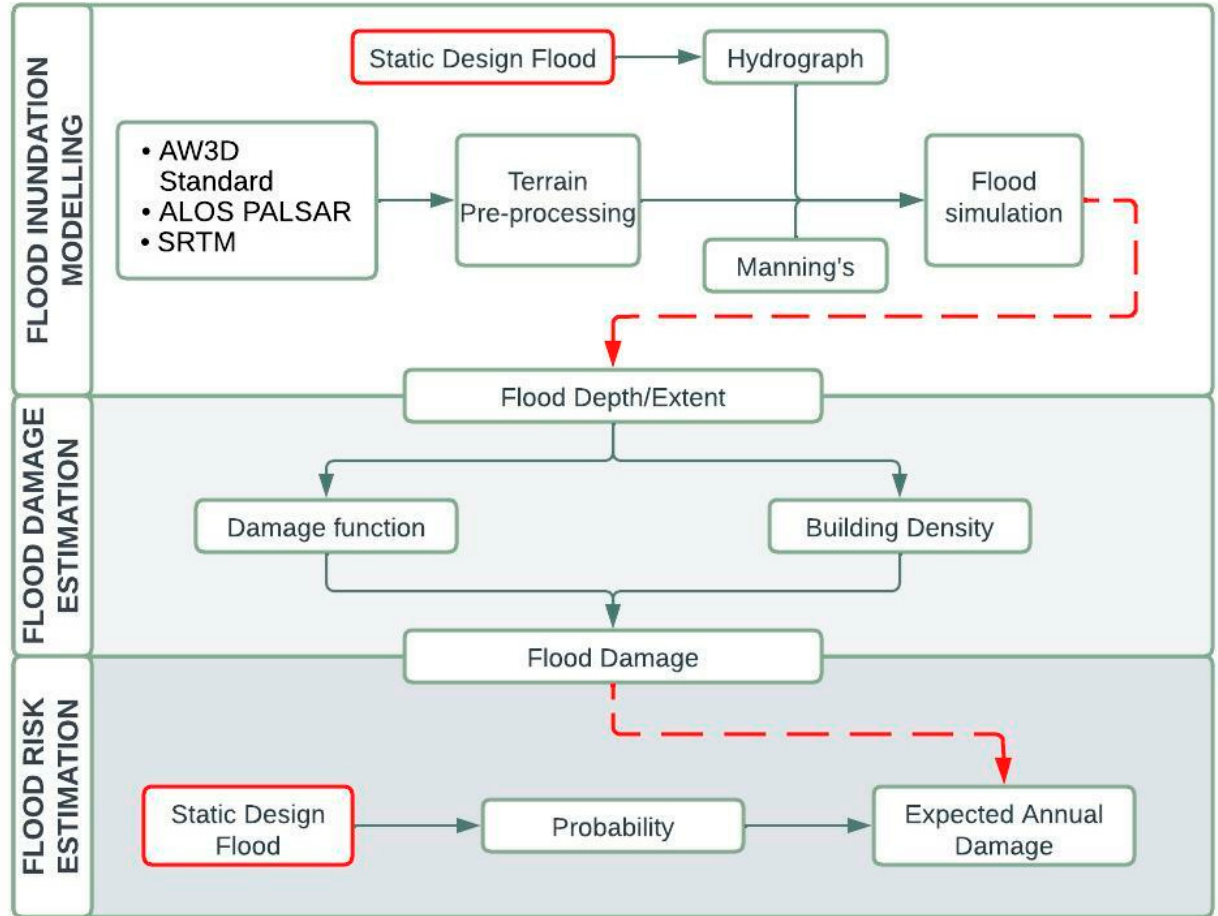
Figure 2. Conceptual workflow for this study. The workflow was repeated for three DEMs with different spatial resolutions.